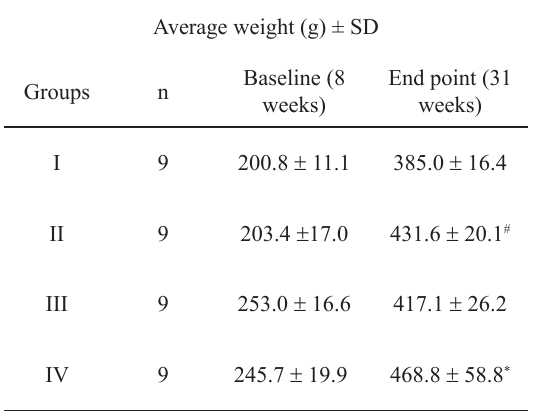
TABLE 4 - Weight(g) distribution in Groups I, II, III and IV at 8 weeks and 31 weeks.